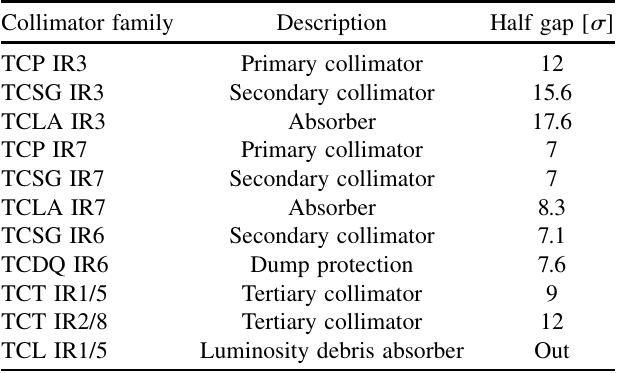
TABLE II. The settings of the collimators not used for scrap- ing throughout the beam study (grouped by families), for both scraping configurations.